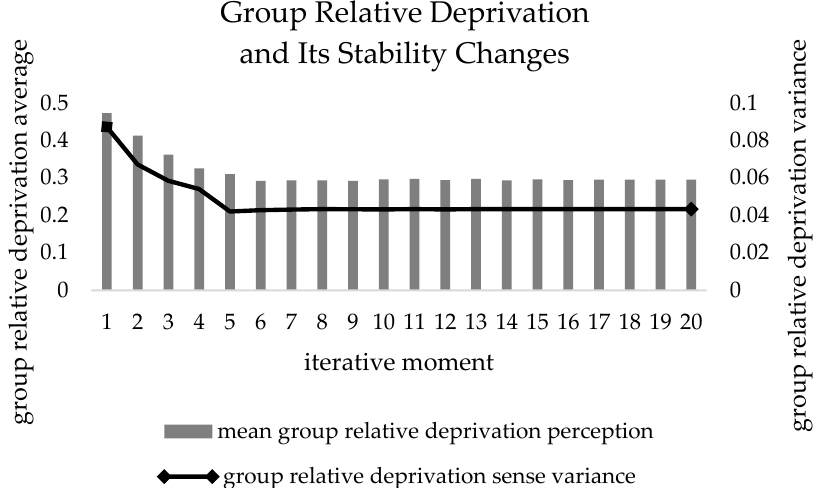
Figure 8. Relative deprivation and its variance update.